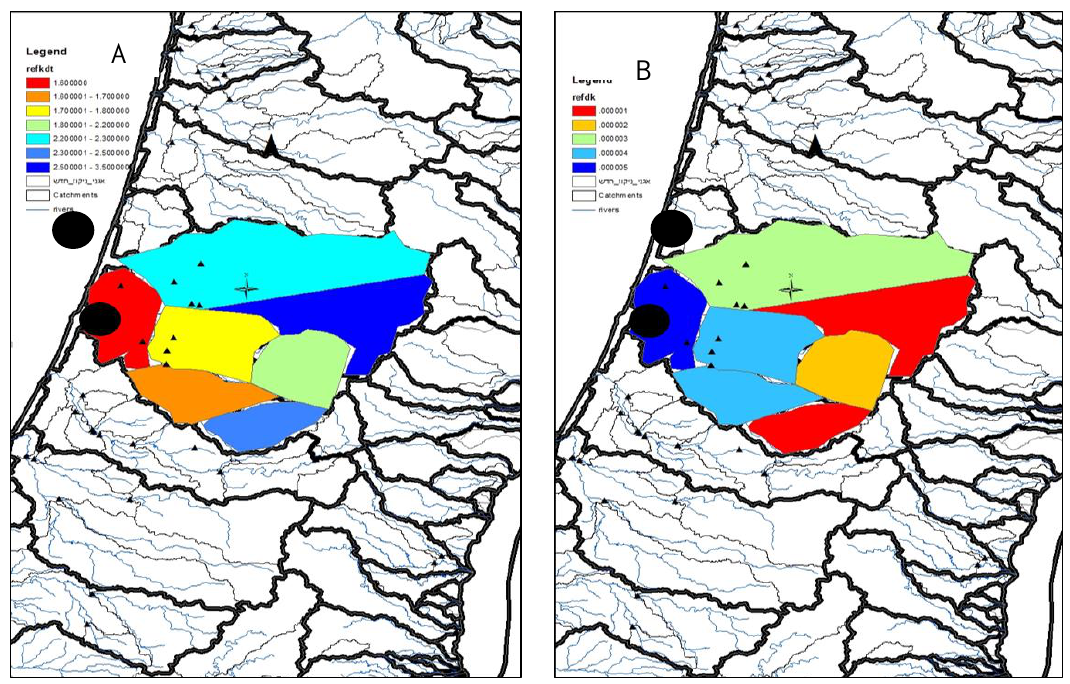
Figure 4. WRF-Hydro different REFKDT (runoff/infiltration rate) and REFDK values (saturation hydraulic conductivity) at the Ayalon basin.